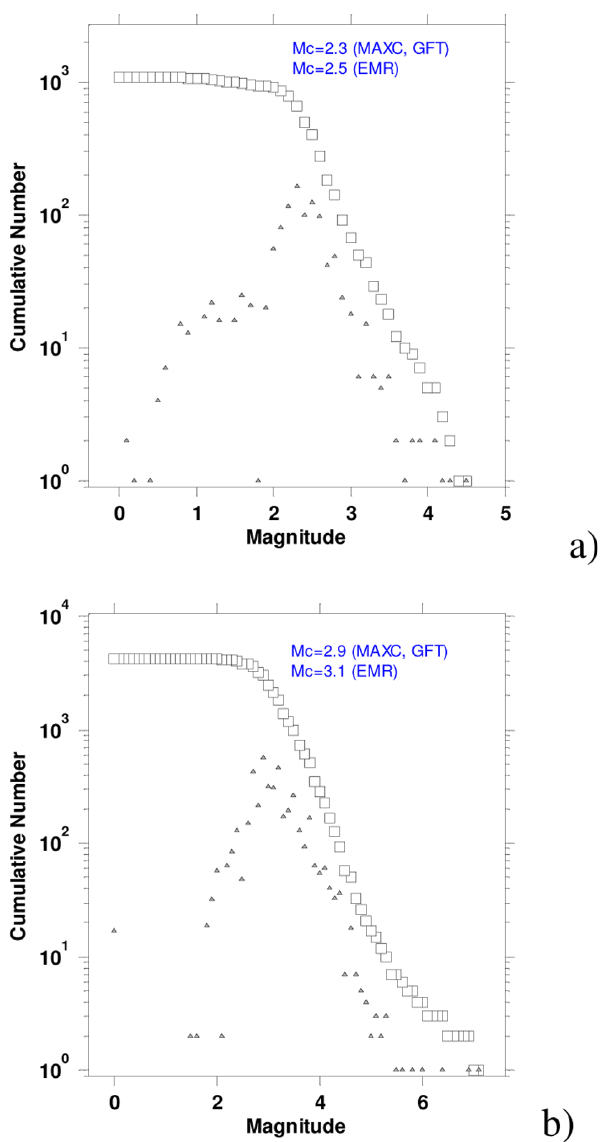
Fig. 5. Frequency-magnitude distribution of (a) crustal and (b) sub- crustal Vrancea